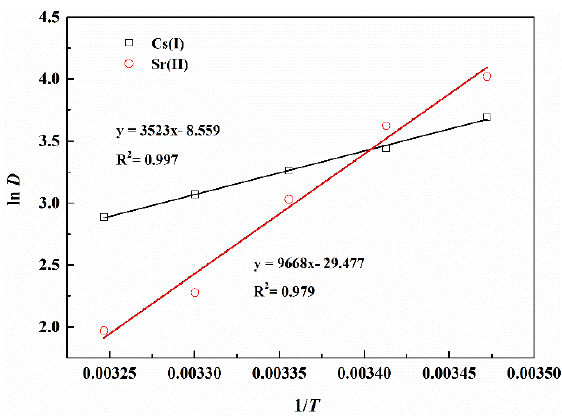
Figure 6. Relationship between ln D and 1/ T . Conditions: [SC4A] (o) = 1 × 10 − 3 M, [Metal] (a) = 1 × 10 − 4 M, pH = 6, contact time = 60 min, shaking speed: 150 rpm.